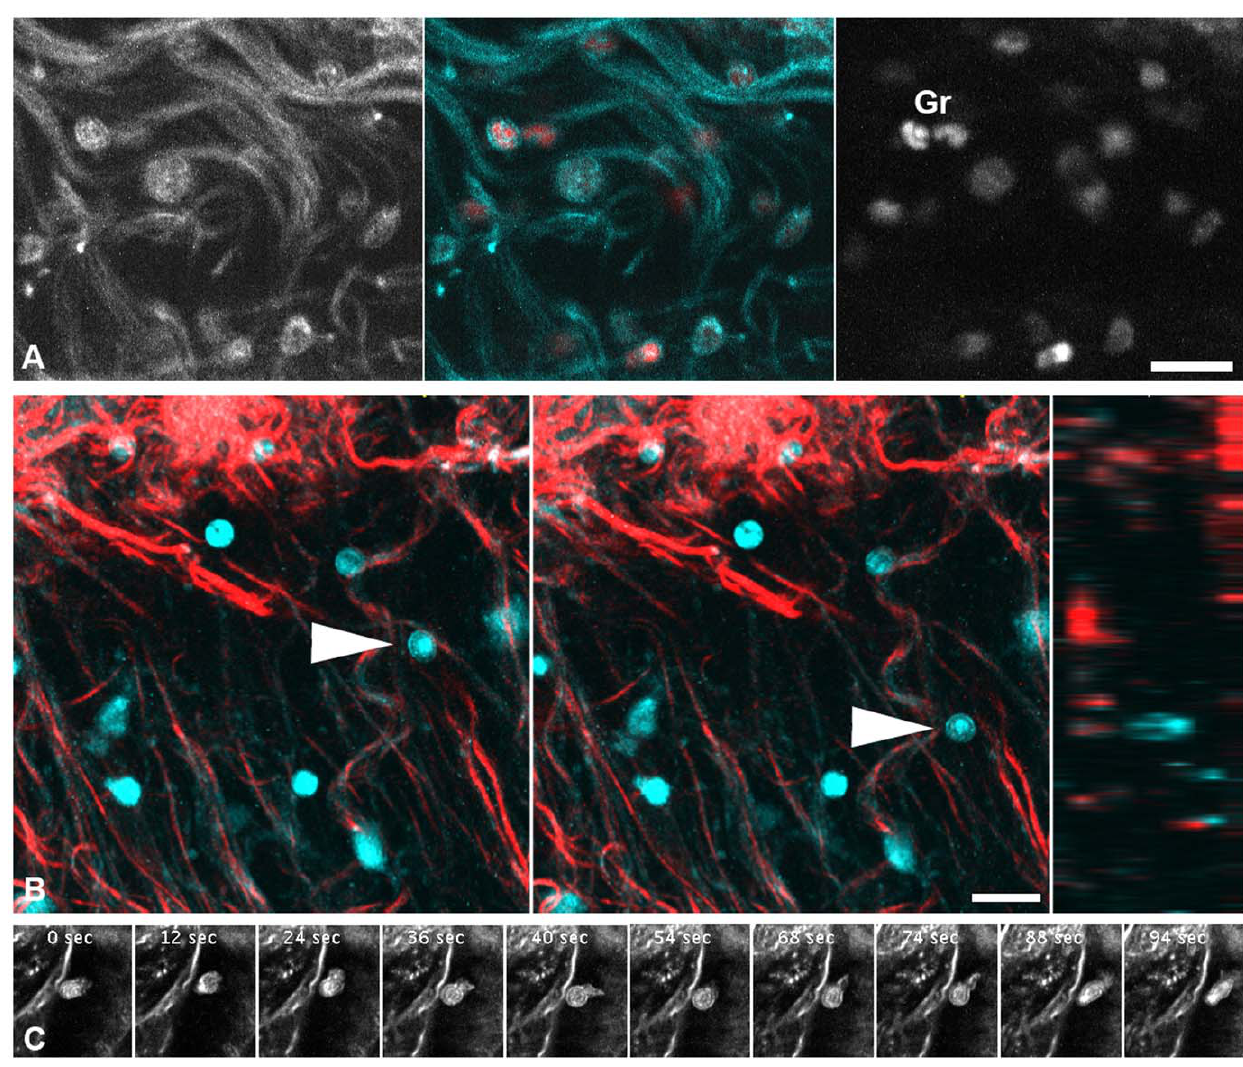
Figure 3. Migrating leukocytes. A) Fixed cremaster muscle, optical section about 50 m m from the surface. THG (left, cyan) revealed shapes reminiscent of migrating leukocytes deep in the tissue. DNA counterstaining (right, red) confirmed that these shapes are nucleated cells. In some cases, nuclei were lobed, a morphology typical for mature neutrophil granulocytes (Gr). Note that some cells identified by DNA stain are not visible in THG. B) Projections of THG (cyan) and SHG (red) in a time series of a freshly explanted cremaster, recorded in forward direction. While most leukocytes were stationary one moved , 25 m m in 385 seconds (arrowheads). Image on the right shows a yz-section (view from the side, at end of the time series) illustrating that the moving cell is inside the tissue, not at the surface. The respective movie is shown in Movie S2. C) Migrating leukocyte in the freshly explanted cremaster forming and retracting pseudopodia. Single optical section. The respective movie is shown in Movie S3. Scale bars are 20 m